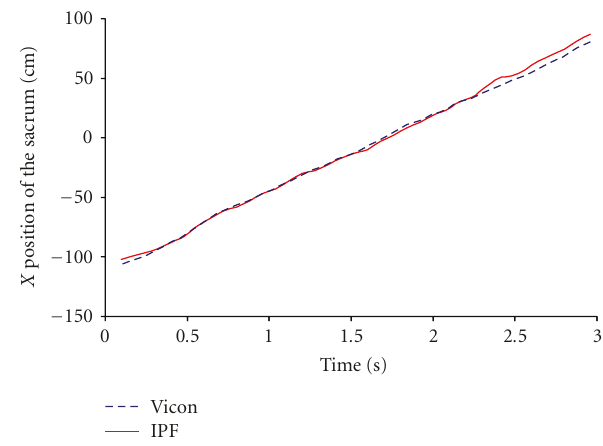
Figure 12: Comparison of X position of the sacrum between the IPF and Vicon systems for a typical